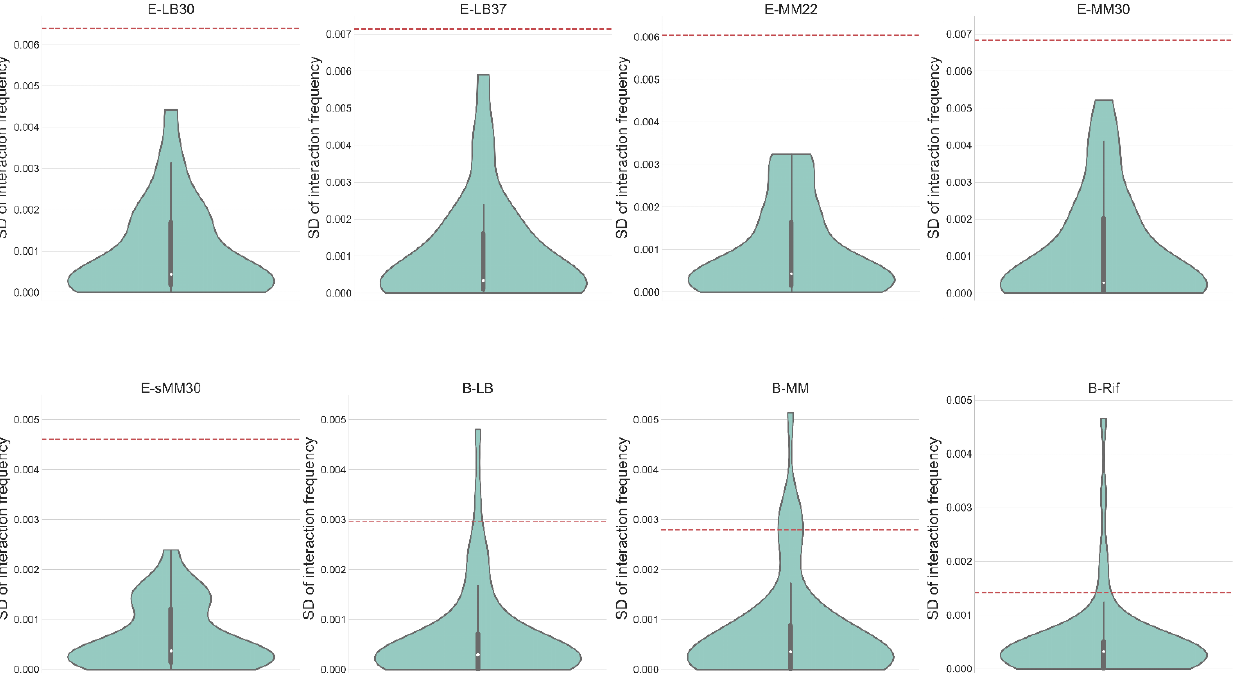
Figure 5. The distribution of standard deviation (SD) of chromatin interaction frequency within SIMs (violin plot) and its comparison with that of TRN (red dashed line). The SD of chromatin interaction frequency within SIMs is clearly lower than that of TRN, indicating lower dispersion and higher uniformity of chromatin interaction within SIMs.